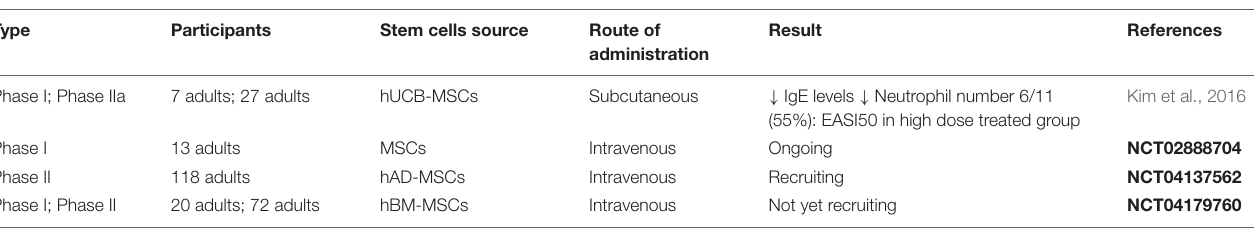
TABLE 2 | Clinical trials of MSCs in